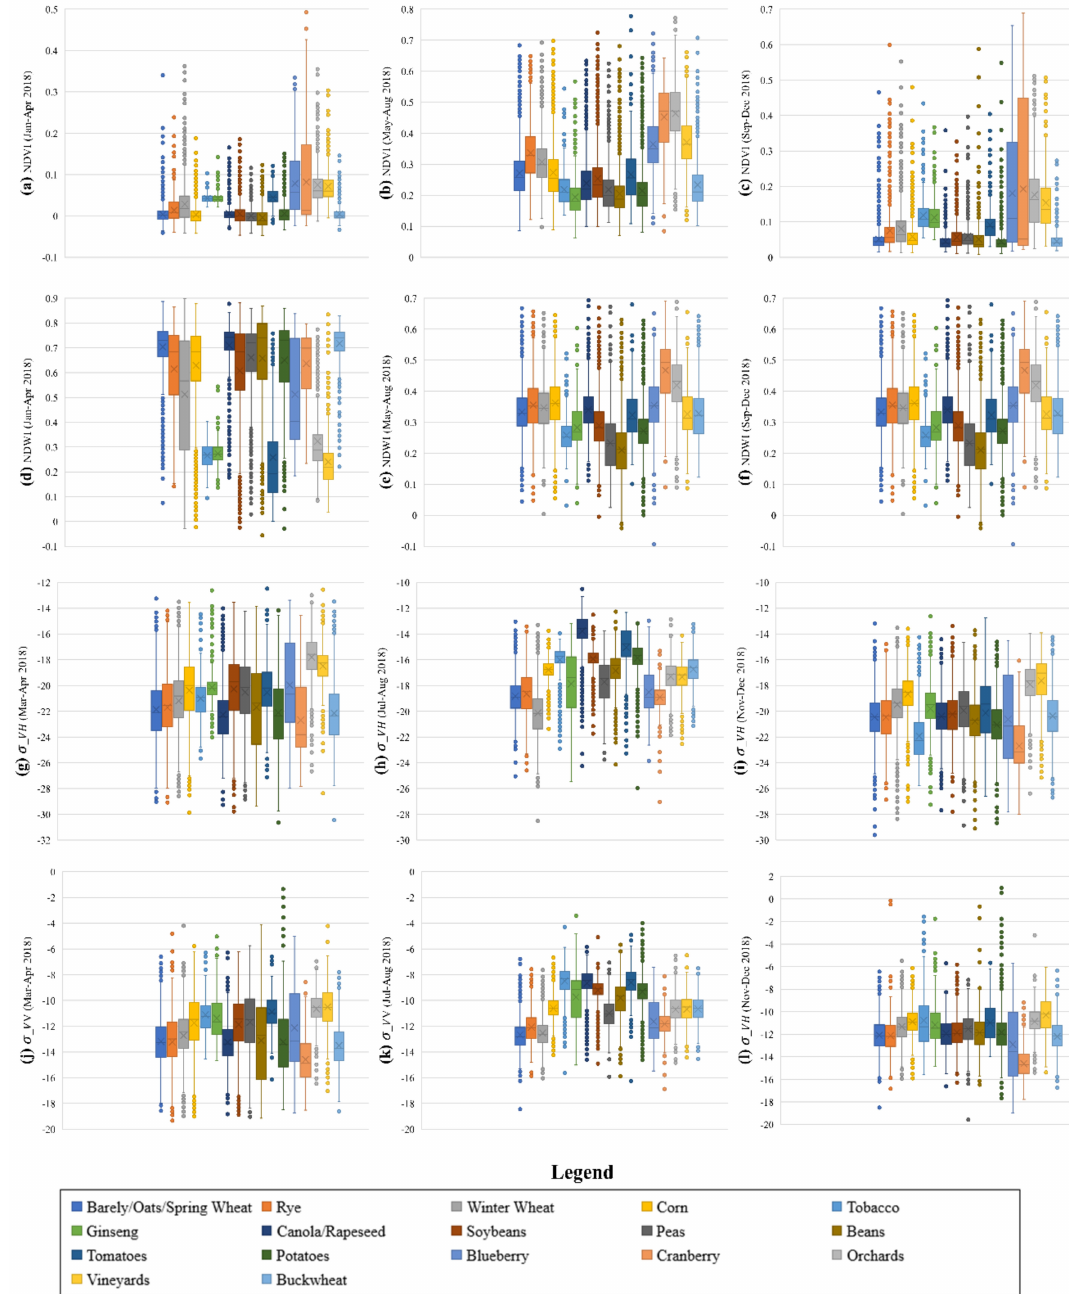
Figure 7. Box plots of the cropland classes using ( a – c ) three mosaic Normalized Di ff erence Vegetation Index (NDVI) features, ( d – f ) three mosaic Normalized Di ff erence Water Index (NDWI) features, ( g – i ) three mosaic backscattering coe ffi cients at the Vertical transmit and Horizontal receive (VH) polarization, ( j – l ) three mosaic backscattering coe ffi cients at the Vertical transmit and Vertical receive (VV) polarization. The cross ( × ) mark indicates the mean